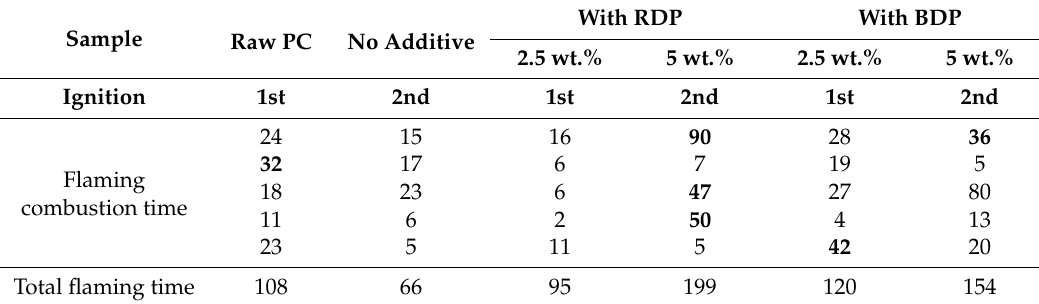
Table 5. Time of the two flaming combustions during UL-94 test. With RDP Sample Raw PC No additive Sample Raw PC